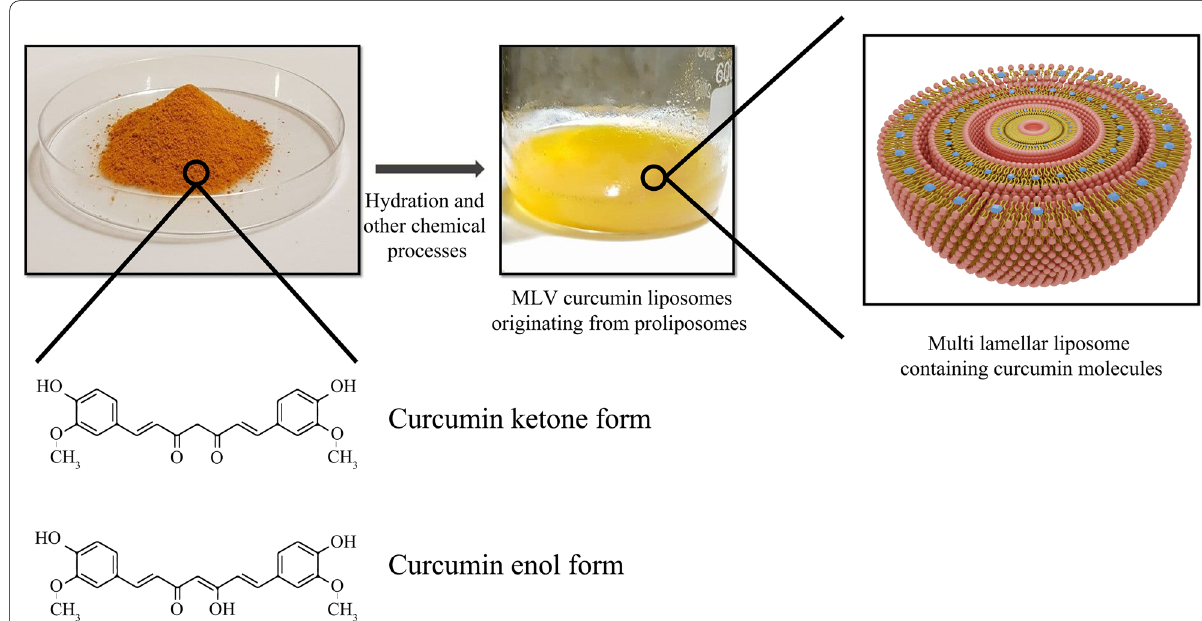
Fig. 10 An overview of curcumin powder and liposomal curcumin synthesis. Chemical reactions performed for liposomal curcumin production and curcumin molecule structure in various forms are simply